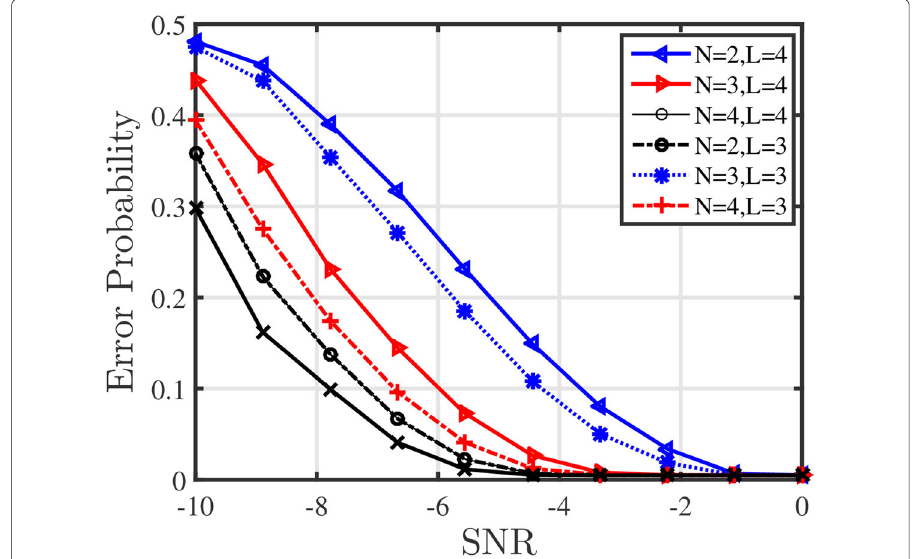
Fig. 2 Error probability of the GWT classifier for different channel conditions and the number of observation vectors for D={BPSK,QPSK} dictionary